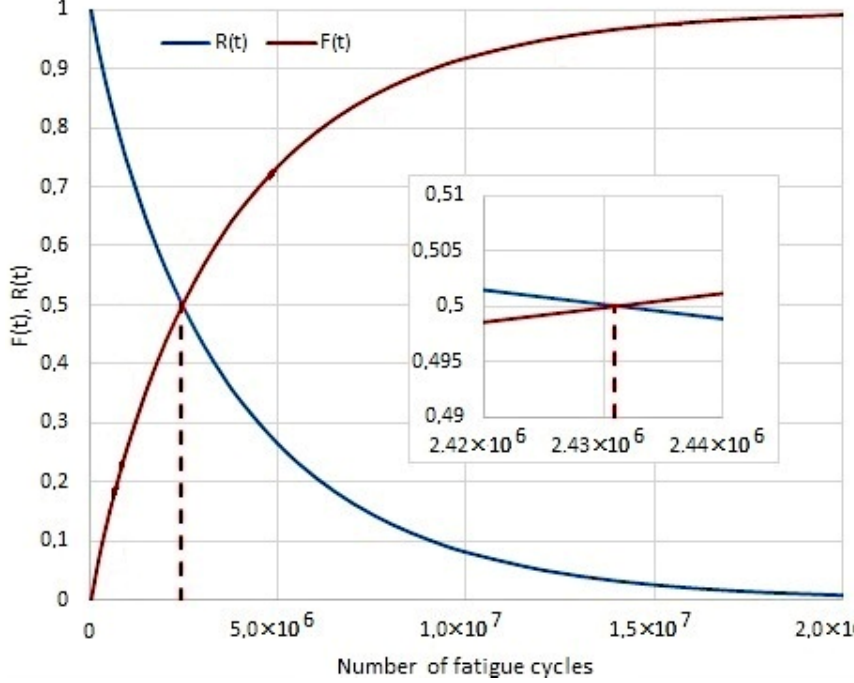
Figure 8. The course R(t) and F(t) for shaft without surface treatment.